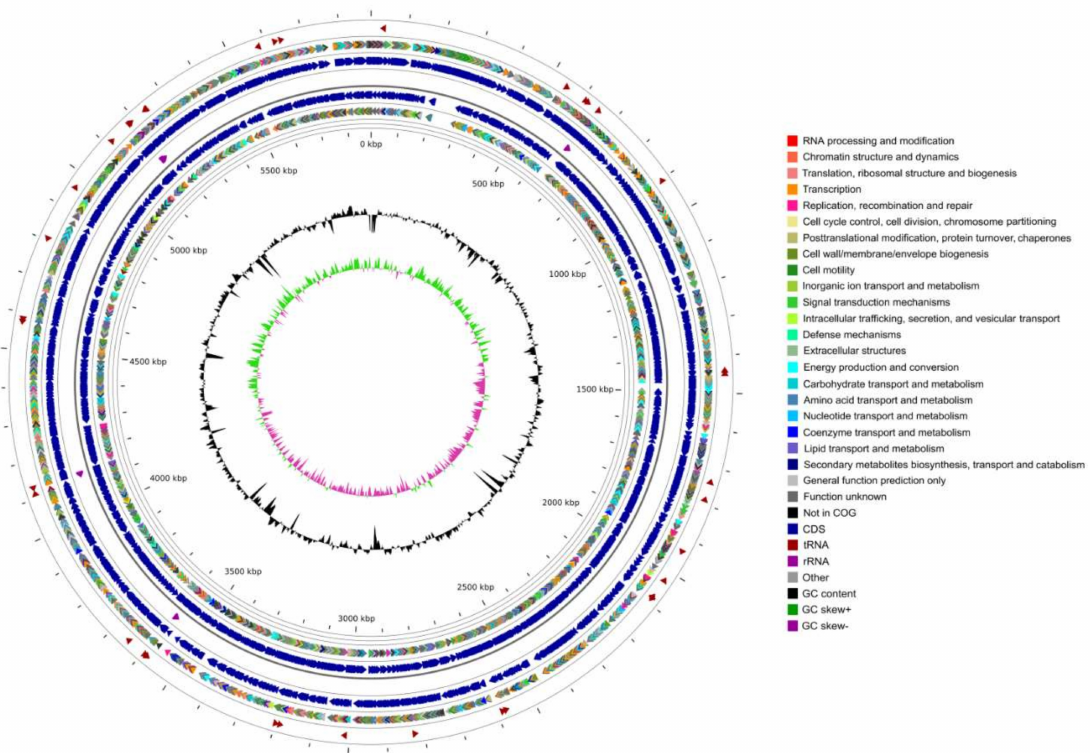
Figure 3. Circular genome map and features of Pseudomonas sp. DY-1. The contents of the featured rings (starting with the outermost ring to the center) are as follows. Ring1: tRNA-related genes; Ring2: the COG annotation gene distribution of the positive strand, distinguished by different colors; Ring3: genes position of the positive strand; Ring4: rRNA genes; Ring5: genes position of the negative strand; Ring6: COG annotation of the negative strand; Ring7: GC content, taking the average GC as the baseline, the outward protruding means higher than the average, and the inward protruding means lower than the value; Ring8: the GC skew (G − C/G + C) values, values < 0 in purple and values > 0 in